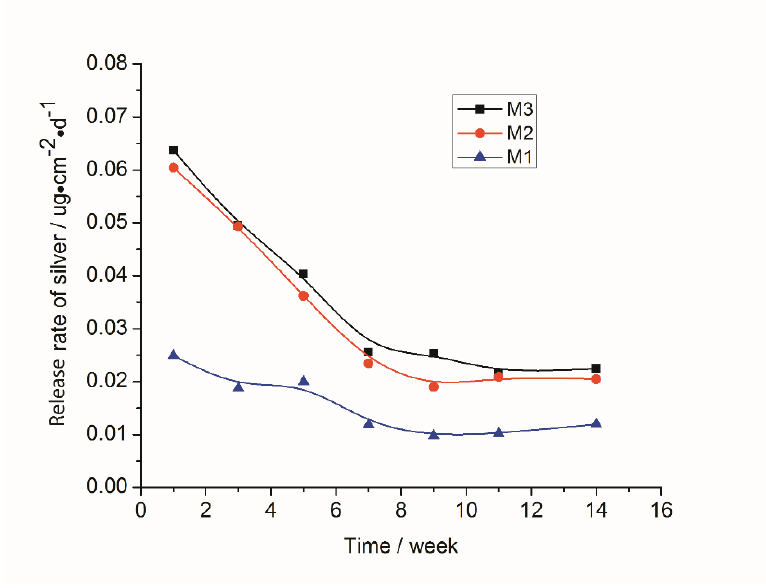
Figure 3. The release rate of silver during the 14 week static leach test.